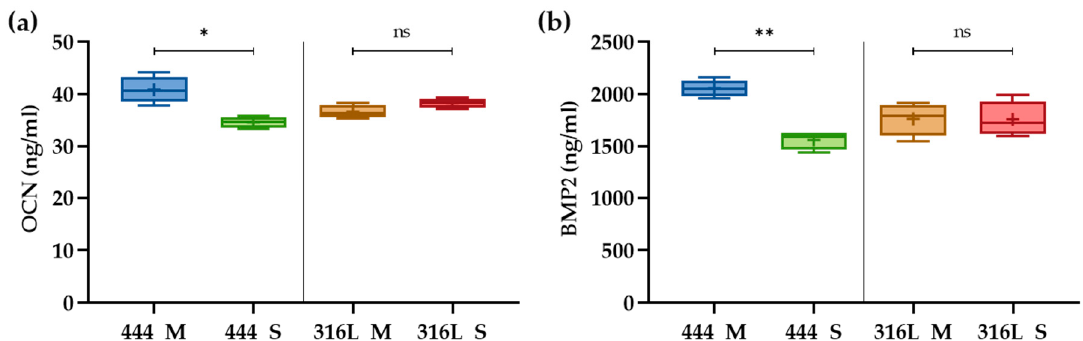
Figure 7. ELISA quantification of bone protein concentration in cell culture supernatant by human osteoblasts on day 21 of culture: ( a ) OCN and ( b ) BMP-2. Boxes show interquartile ranges, horizontal lines within the boxes indicate the median, + shows the mean and whiskers denote minimum and maximum values ( n = 3, 2 samples for each group per experiment). Statistical analysis was conducted by unpaired t test, * p < 0.05, ** p < 0.01, ns: no statistical significance.